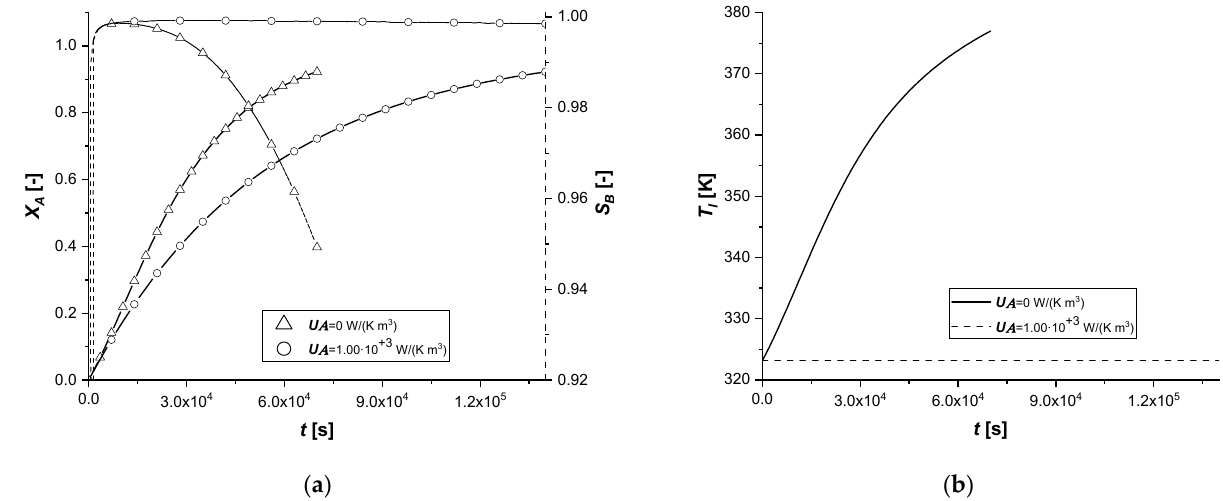
Figure 33. EW UA investigation. ( a ) Bulk profiles over time of X A and S B . ( b ) Bulk profile of T l over time.